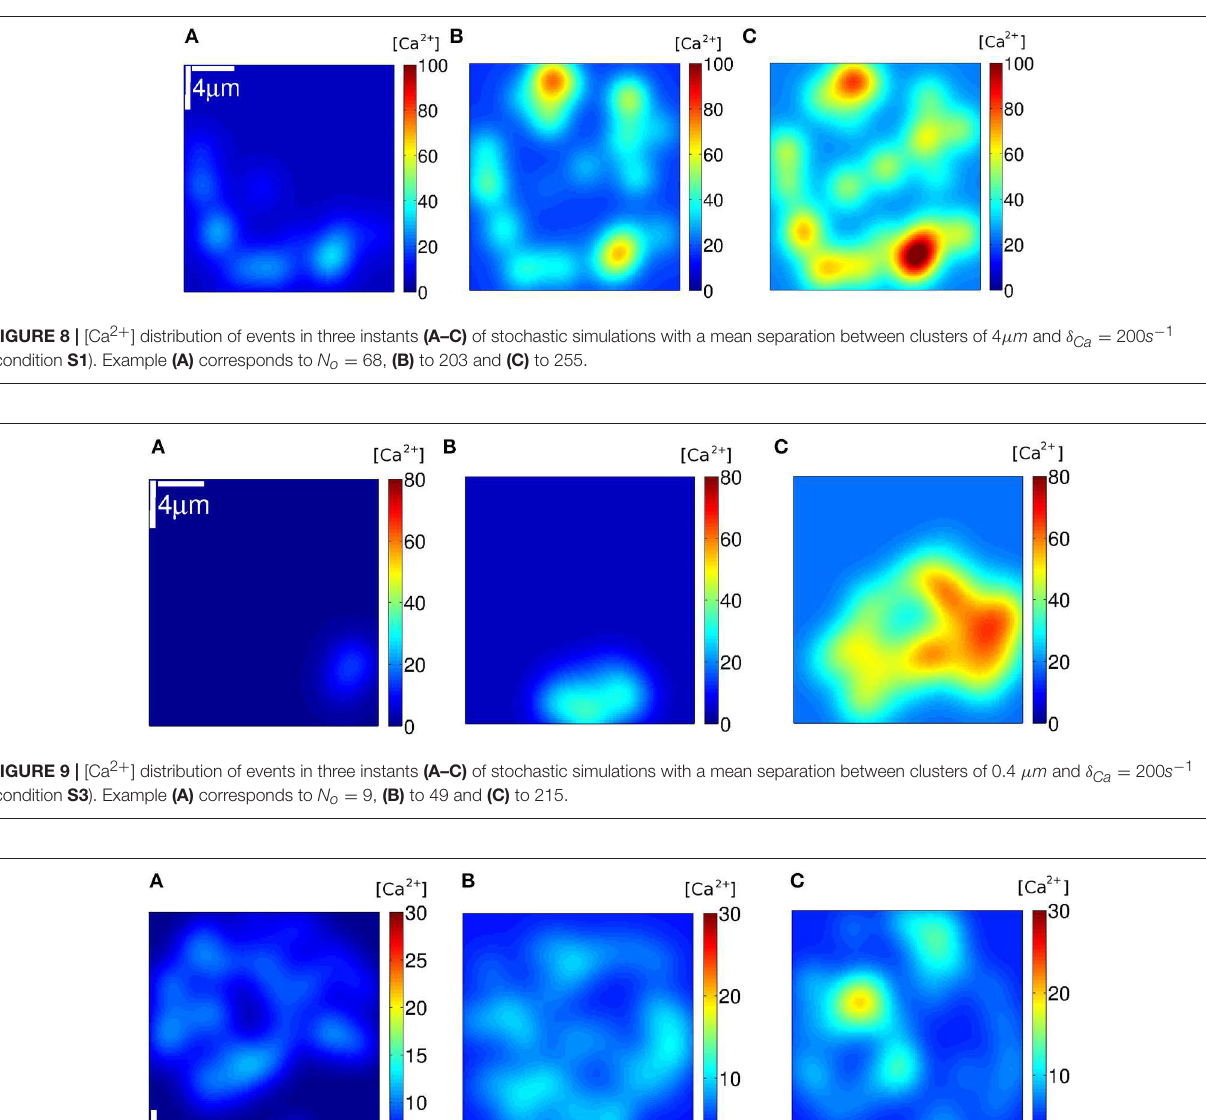
FIGURE 10 | [Ca 2 + ] distribution of events in three instants (A–C) of stochastic simulations with a mean separation between clusters of 0.4 µ m and δ Ca (condition S4 ). Example (A) corresponds to N o